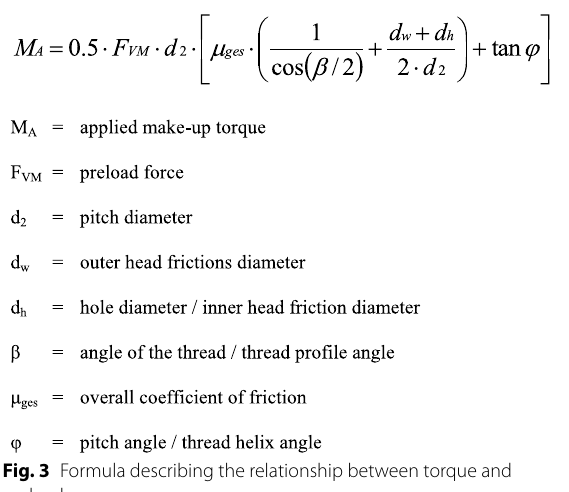
Fig. 3 Formula describing the relationship between torque and preload